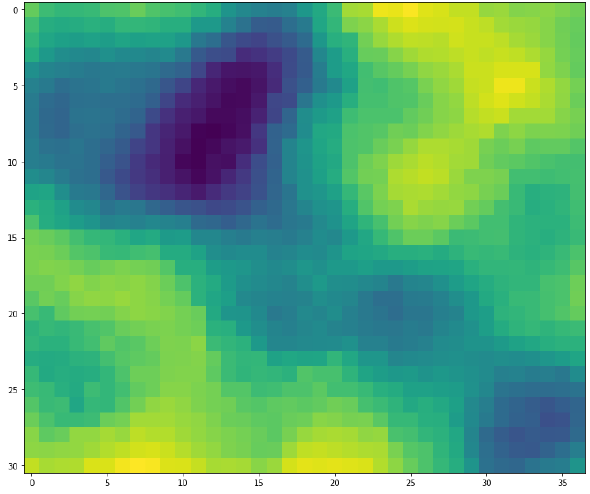
Figure 8. Zoom in one of the change zones (Dark Blue colour represents volume loss change zones with NDEI values close to -1, and yellow colour represents no change zones with NDEI values close to